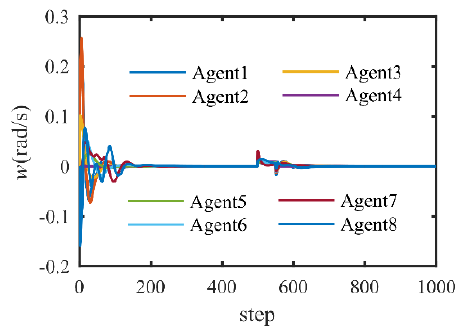
Figure 7. Angular rate control with the proposed controller.